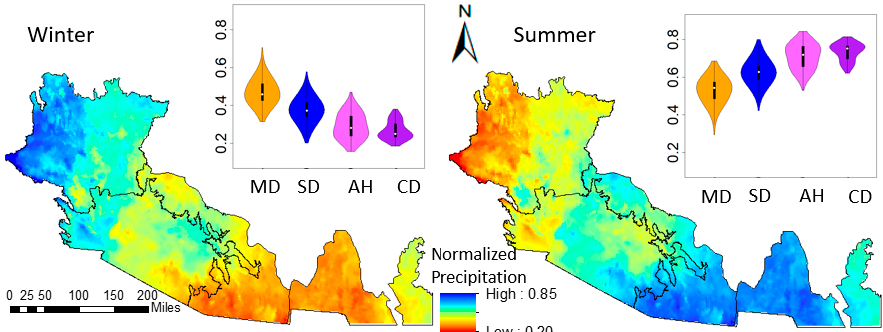
Figure 3. The average seasonal precipitation percent showing the east–west gradient of winter (January to June: left) and summer (July to December: right) in the four ecoregions is computed by dividing the sum of total seasonal precipitation by the total annual precipitation for 2000-2015. The distributions of average season precipitation percent for each region are shown in the density plots where MD = Mojave Desert, SD = Sonoran Desert, AH = Apache Highlands, and CD = Chihuahuan Desert [24,29].